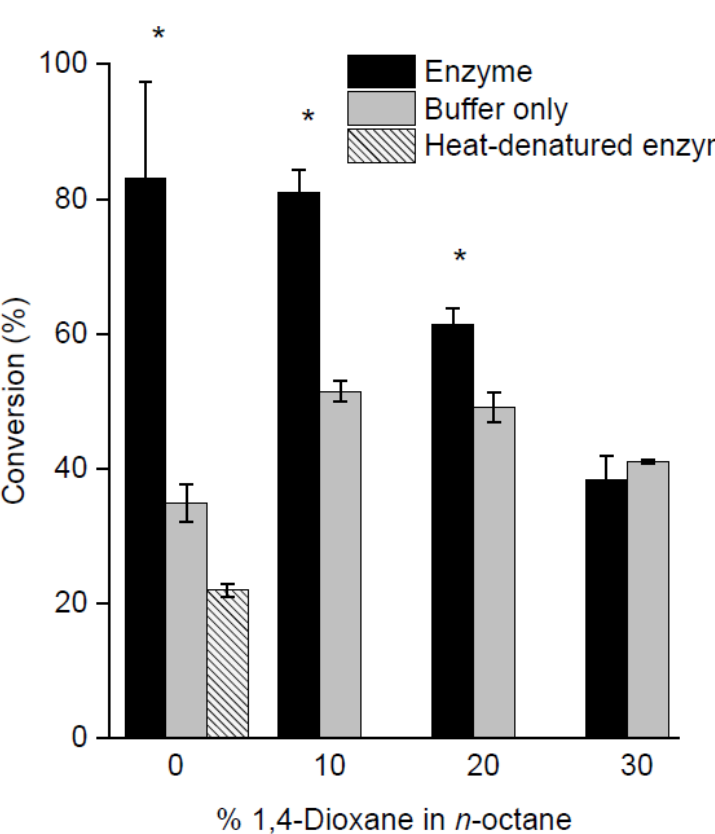
Figure 4. Graph showing percentage conversions of m -methoxyphenol and triethylsilanol in varying percentages of 1,4-dioxane in n -octane (solvent mixtures) after 72 h. A one-tailed Student’s t -test assuming unequal variance was performed, comparing each enzyme to its control. Comparisons resulting in a p < 0.05 were deemed to be significant and are marked with *.